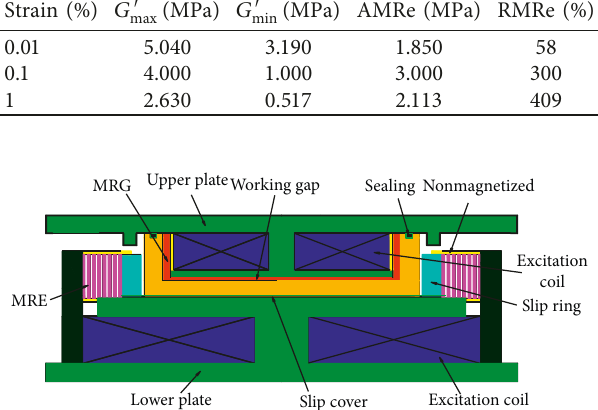
Figure 4: Schematic design of the MRG/MRE smart